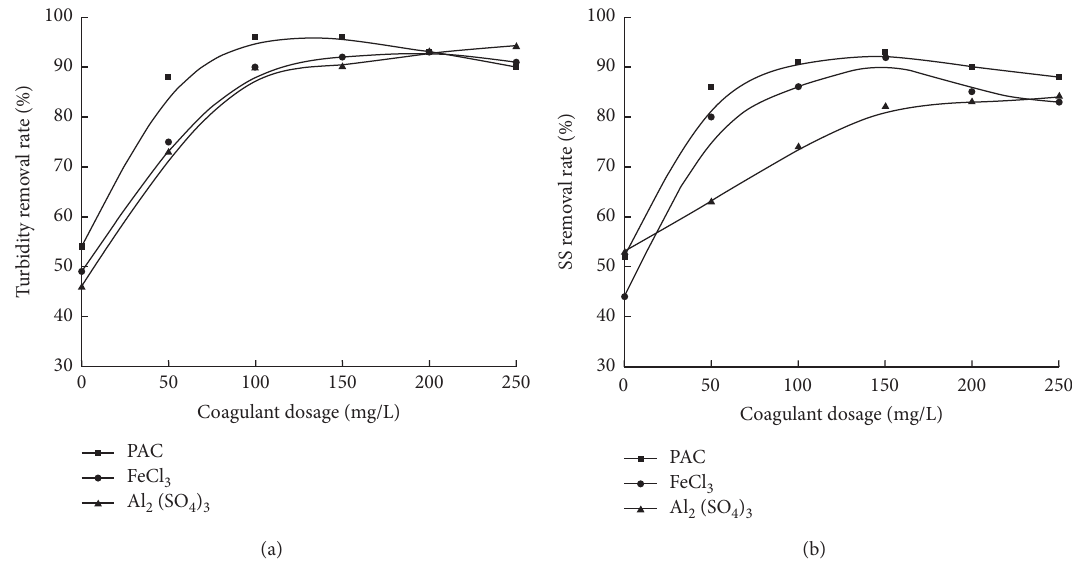
Figure 2: Influence of coagulant dosage on turbidity, SS removal rate. (a) Influence of coagulant dosage on turbidity removal. (b) Influence of coagulant dosage on